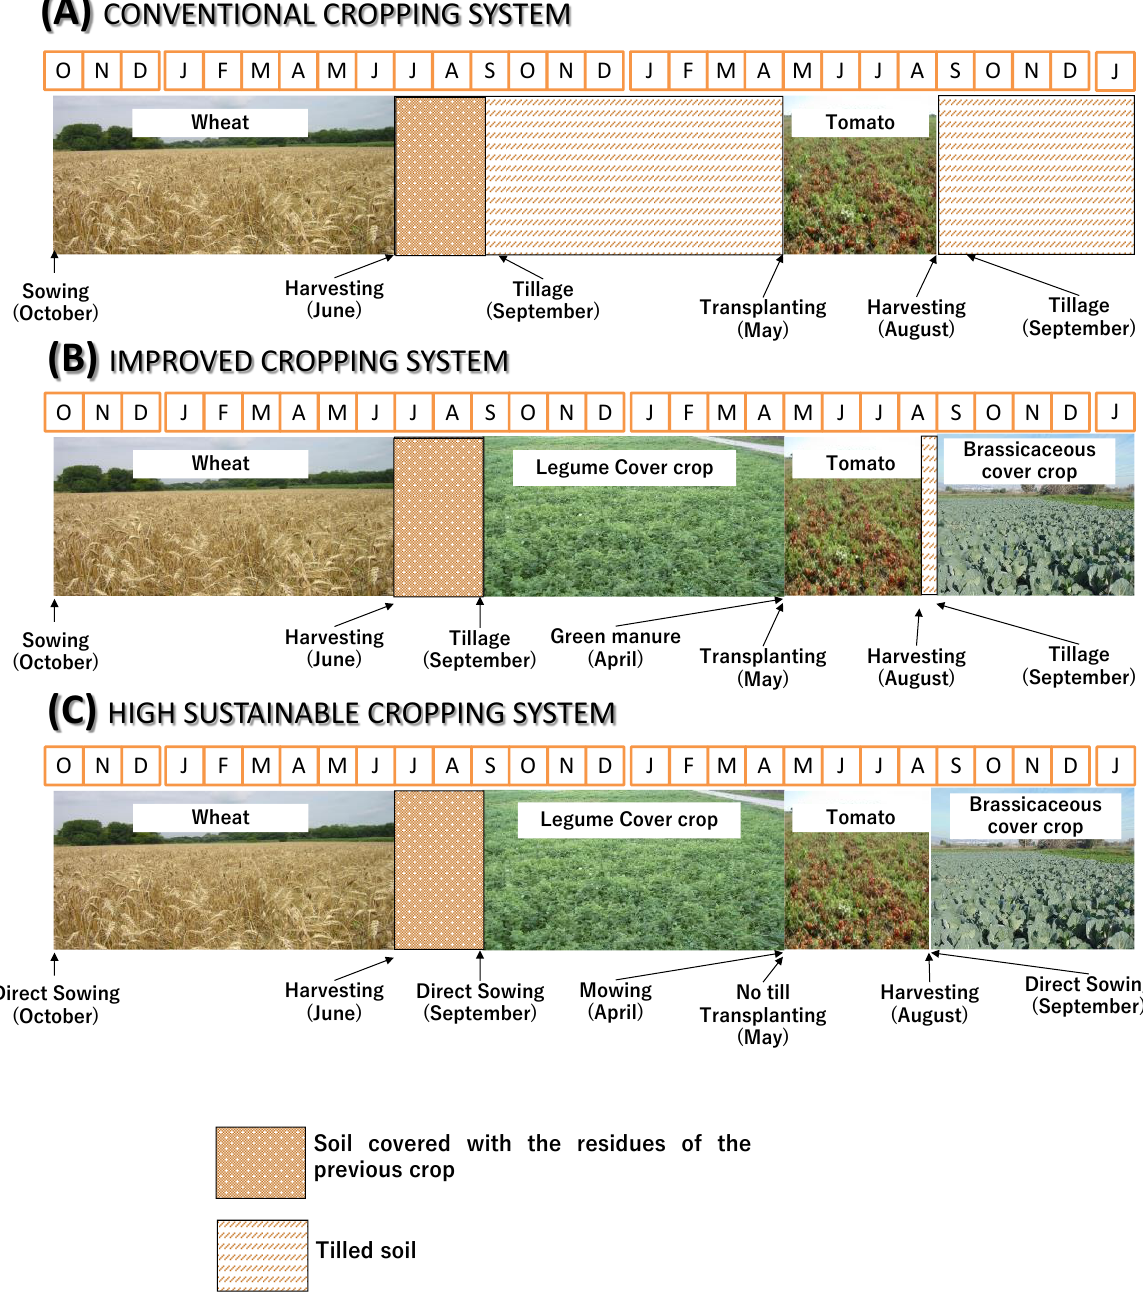
Figure 1. Comparison between conventional ( A ), improved ( B ), and high sustainable cropping systems ( C ) to support the adoption of cover cropping strategy for improving the sustainability of agro-ecosystems.